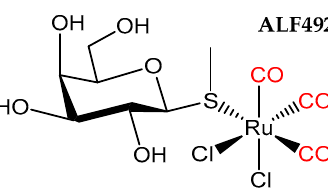
Figure 19. Galactose chelated three carbonyl ruthenium complexes.